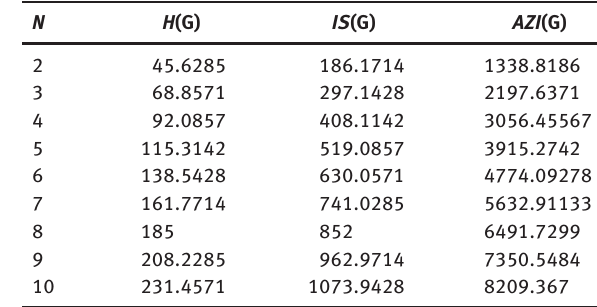
Table 6: Comparison among R where α = 1